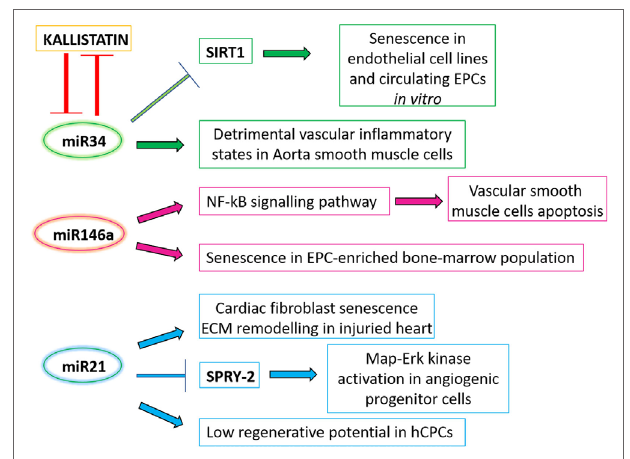
FiGURe 2 | A schematic panel of the circulating microRNAs analyzed in the text and their related effects. ECM, extracellular